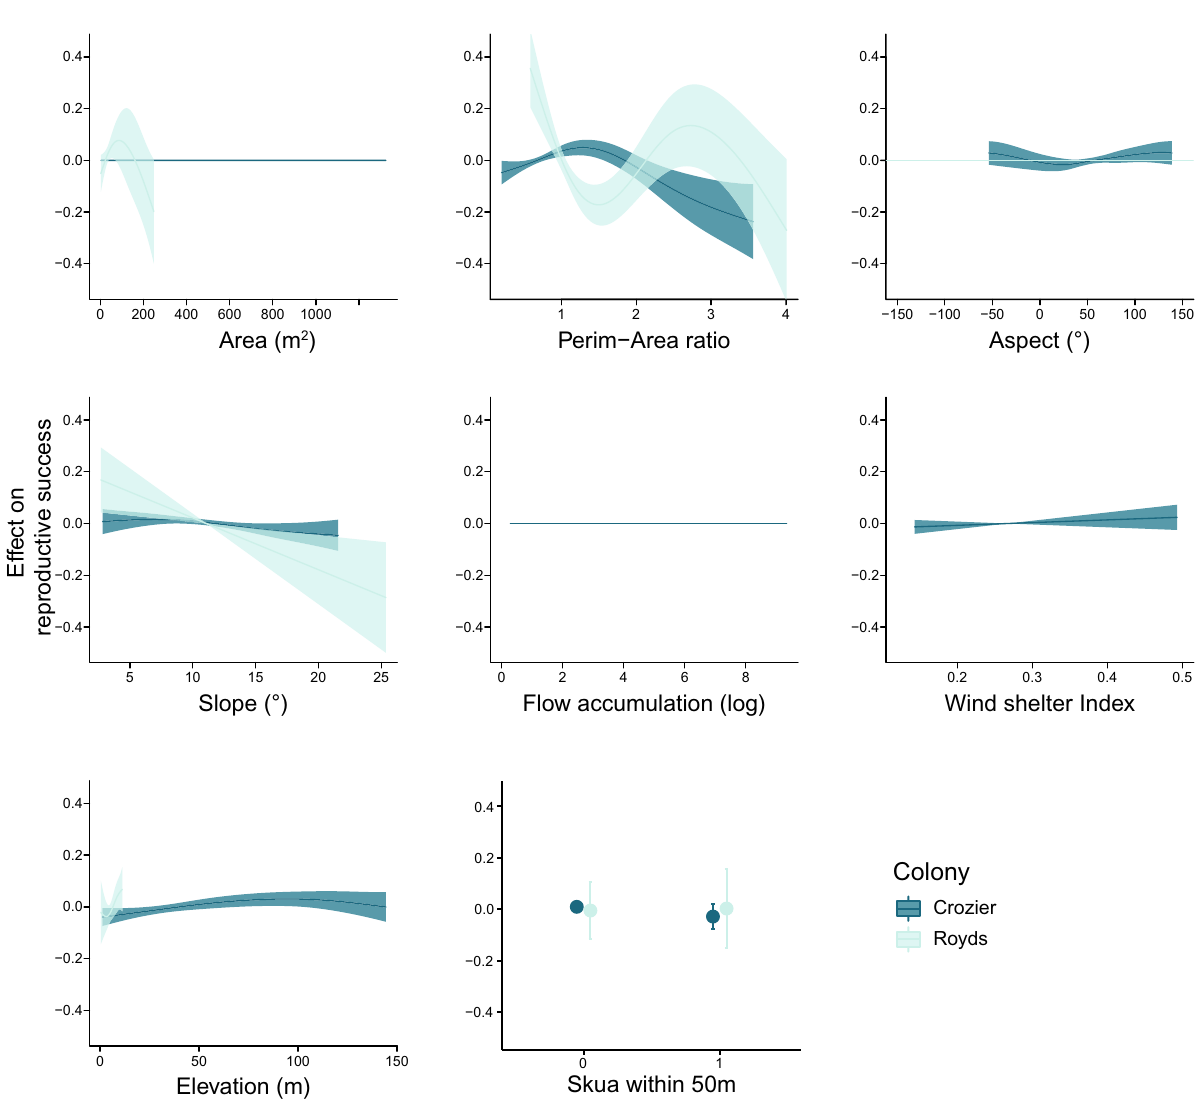
Figure 4. Modeled relationships (using generalized additive models) between nesting habitat characteristics and reproductive success (chicks per pair) of Adélie penguins at Cape Crozier and Cape Royds, Ross Island, Antarctica, 2014–2017. Effects are relative to mean reproductive